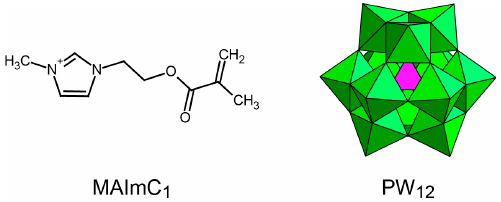
Figure 1. Molecular structure of the MAImC 1 cation ( left ) and the dodecatungstophosphate (PW 12 ) anion ( right ). anion ( right